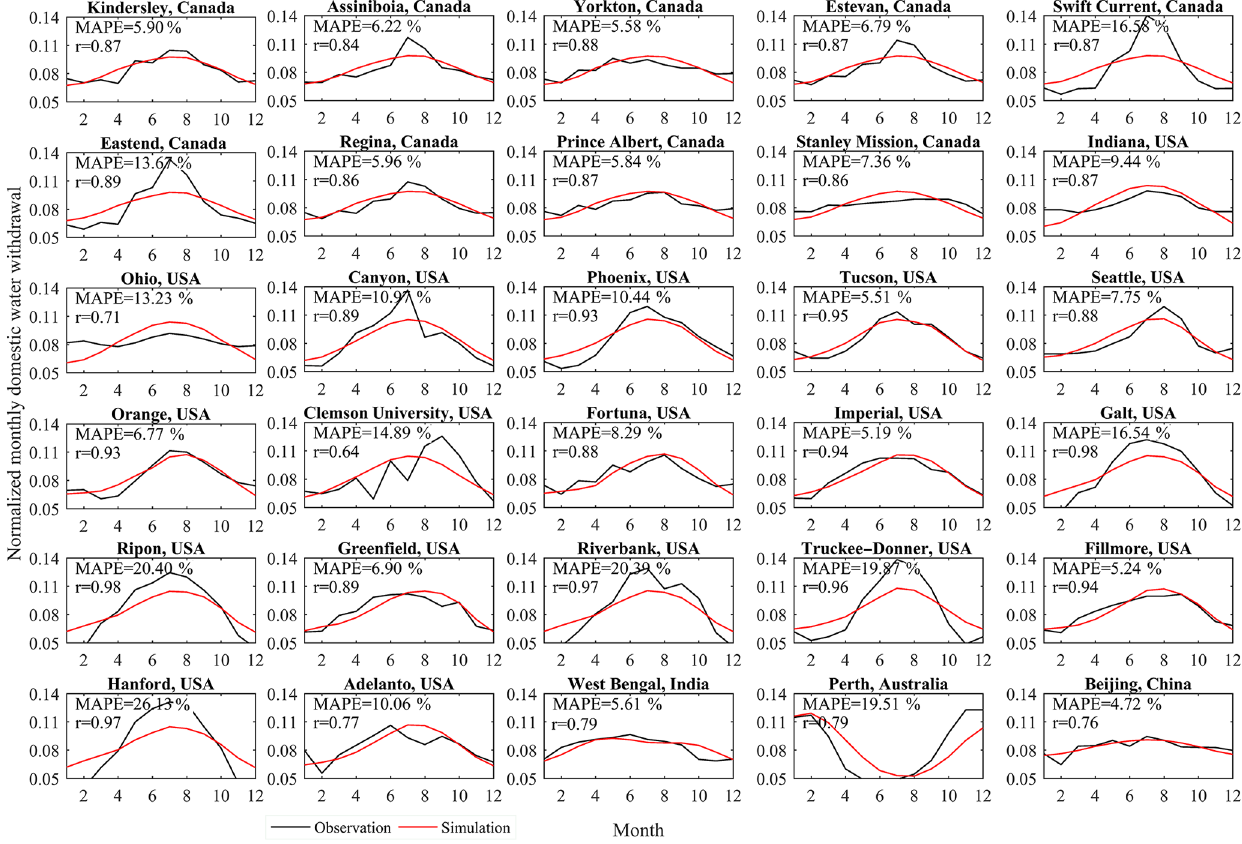
Figure 1. Comparison between simulated and observed monthly domestic water withdrawal in 30 global regions: the normalized monthly water withdrawal is the proportion of monthly water withdrawal to the total annual water